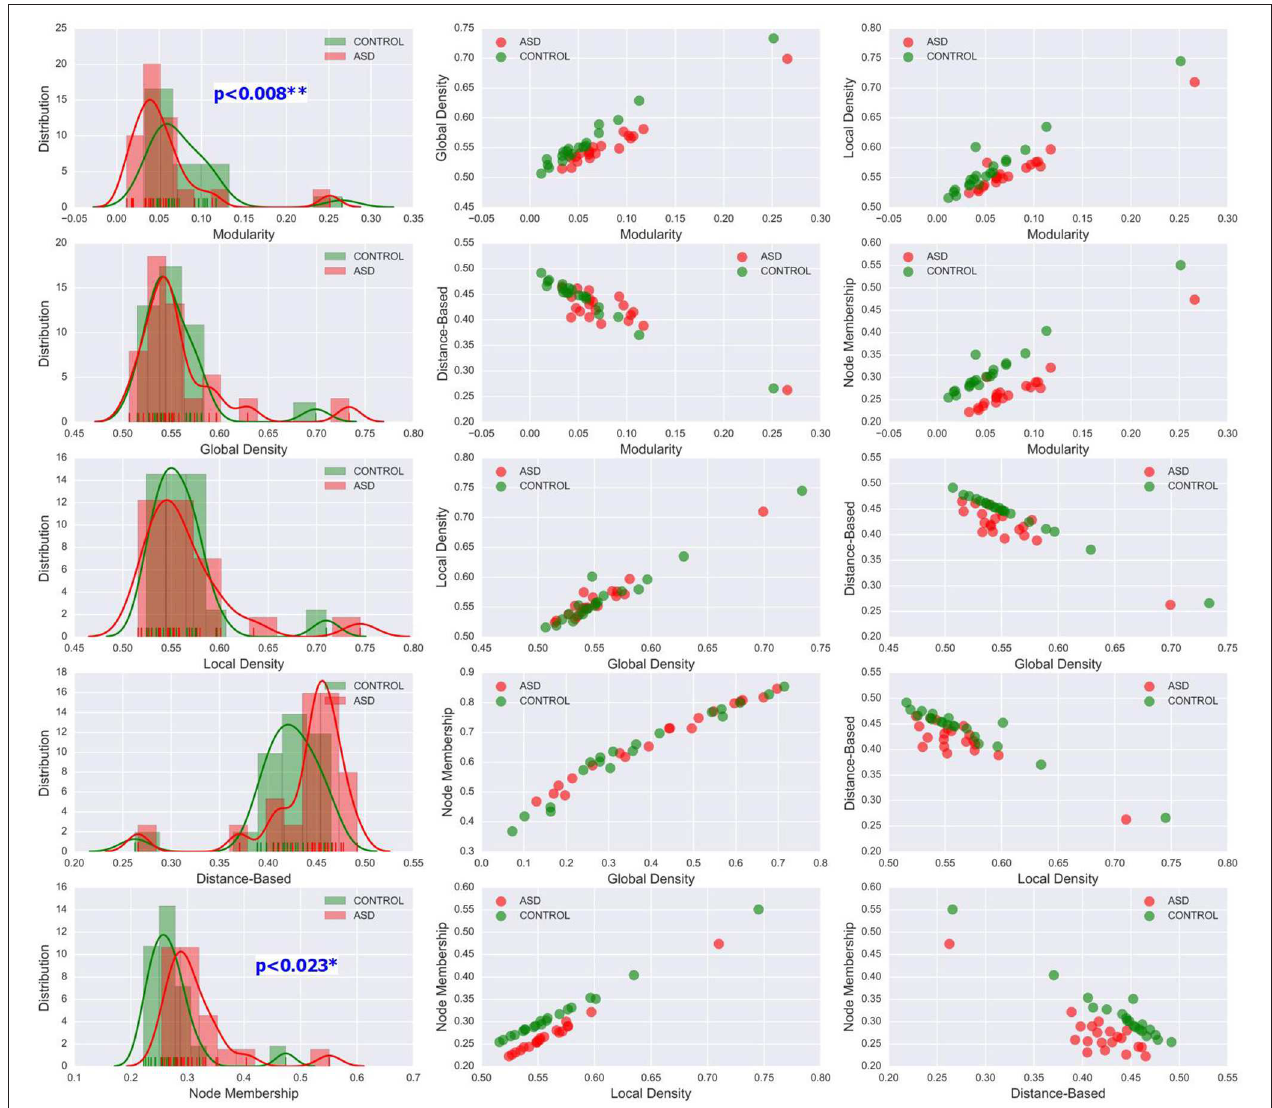
FIGURE 7 | Left column: KDE plots of variations in the five community pattern metrics across subjects and clinical groups in the STA dataset at threshold T = 0.4 with a Gaussian kernel bandwidth of 0.02. These plots show significant differences in the distribution of community structure metrics between the two groups. Middle and right column: organization of ASD and control group data visualized by scatter plots of all pairs of community pattern metrics.